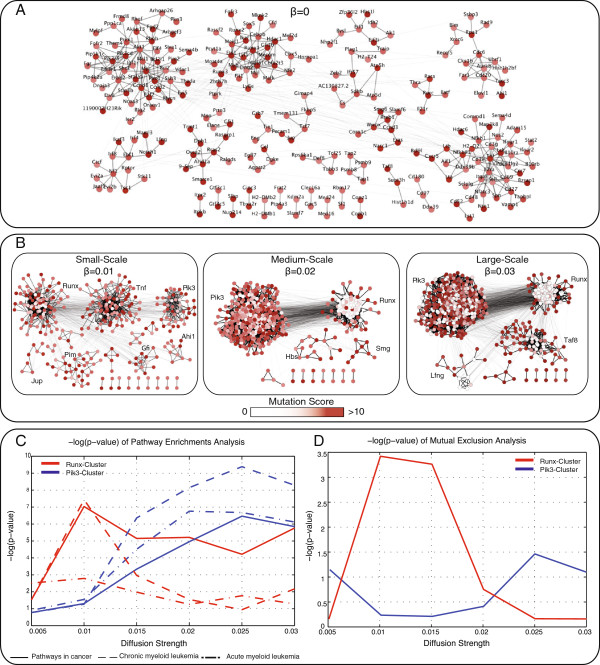
Gene clusters across the diffusion scales. A) The CIS genes shown in the context of the interaction network which are significant without any diffusion (β = 0). These genes represent the major sources of mutation score, and drive low scoring genes in the diffusion process. B) Overview of the identified ReMIC gene clusters at three scale levels: small-, medium- and large-scale. The color of the nodes reflects the mutation score before diffusion. Two major gene clusters, Runx- and Pik3-cluster are apparent across the scales. C)p-values of pathway enrichment analysis of three pathways in the KEGG database for two detected clusters in all diffusion scales. Both clusters are highly enriched for pathways in cancer across a range of scales. The Runx- and Pik3-cluster show strongest enrichment for the small- and large-scale, respectively. D)p-values of mutual exclusivity analysis for the two ReMIC gene clusters. Both clusters are significantly mutually exclusive across all scale levels. The minimum p-value is, however, attained for the scale at which the strongest KEGG enrichment was observed.